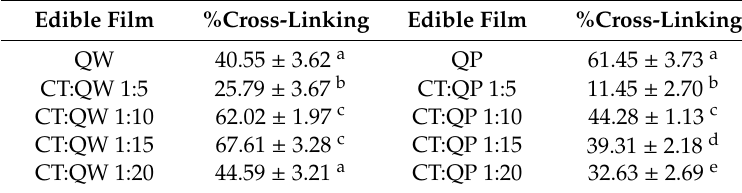
Table 2. Degree of cross-linking when TG is added to edible films made with protein isolates of two quinoa